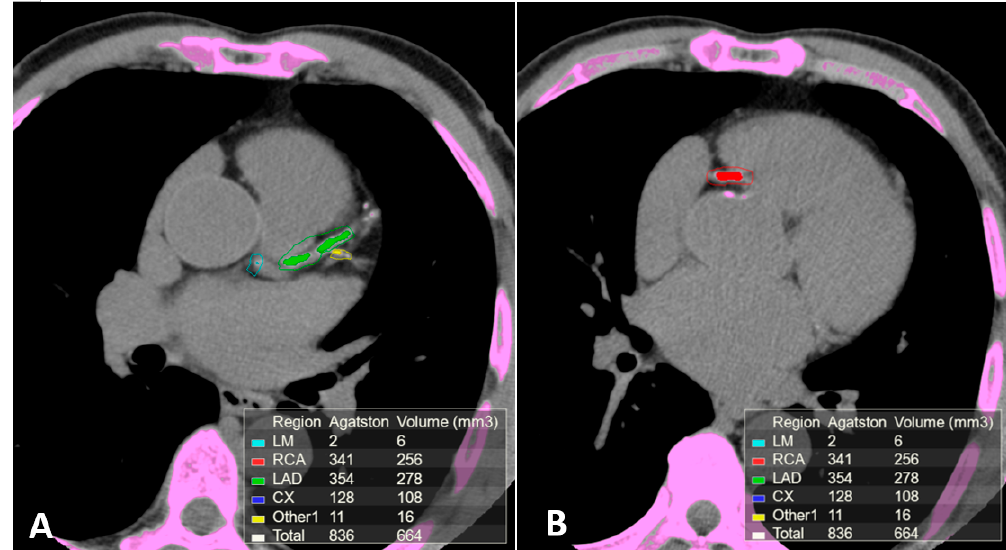
B Figure 1. Calcium scoring (CAC) performed on a non-contrast ECG-gated CT scan of a patient with coronary arteries calcifications using commercial software Vitrea 6.0. The software automatically highlights all the structures attenuating at least 130 Hounsfield units (pink). Regions of interest (ROI) were manually placed around the coronary arteries calcifications using di ff erent colors for each coronary segment. The partial and overall Agatston score and volume of the calcifications included in the regions of interest are summarized in the box on the bottom of the images. ( A ) Calcifications in the left main, anterior descending and 1st diagonal branch. ( B ) Calcification in the proximal segment of the right coronary